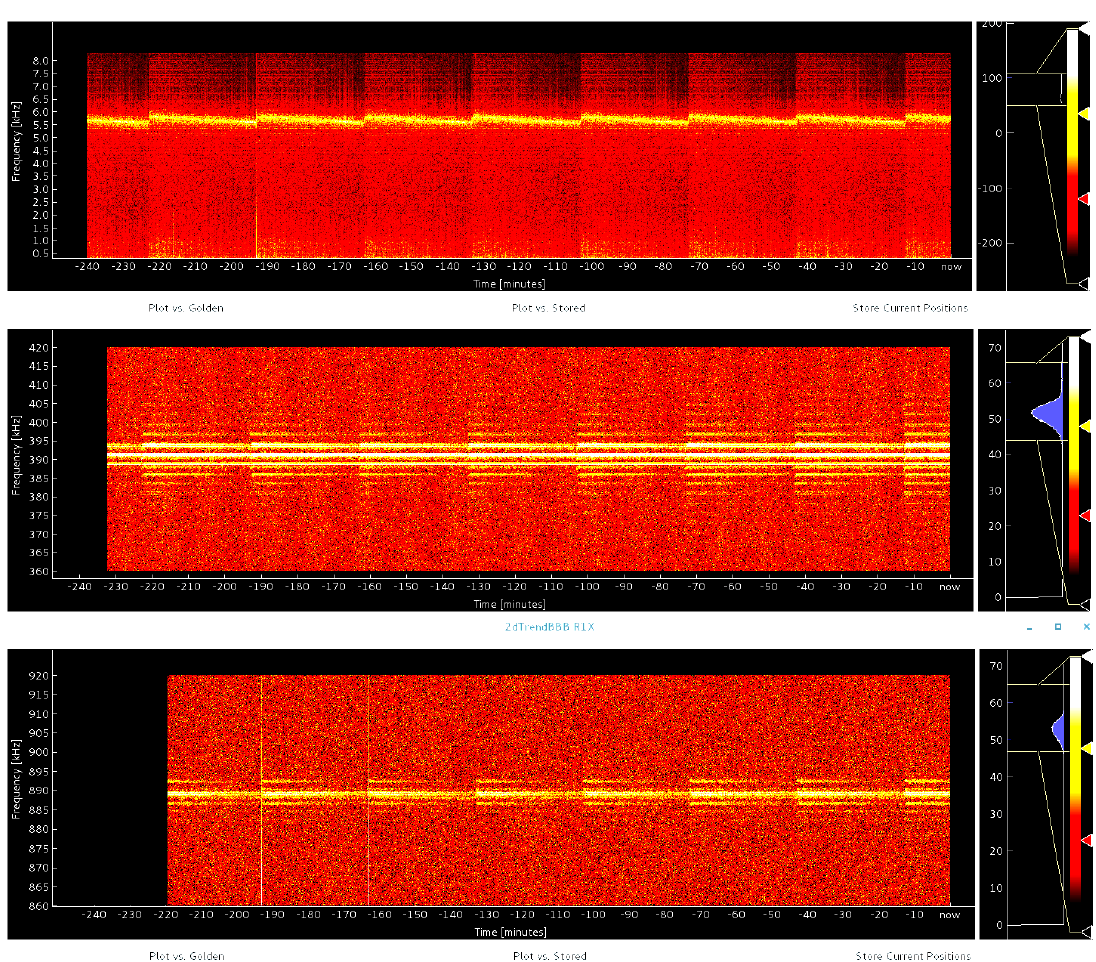
Figure 8. The longitudinal and transverse frequencies for the 1.5 GeV storage ring. In the longitudinal plane (synchrotron frequency), one can see the effects of the top-up injections ( top plot ). In the vertical plane ( middle plot ), one can see the signal is strongest around 390 kHz, but lines for higher and lower frequencies, albeit weaker, can be seen for higher and lower frequencies. A similar, but less pronounced, effect can be observed in the horizontal plane ( bottom plot